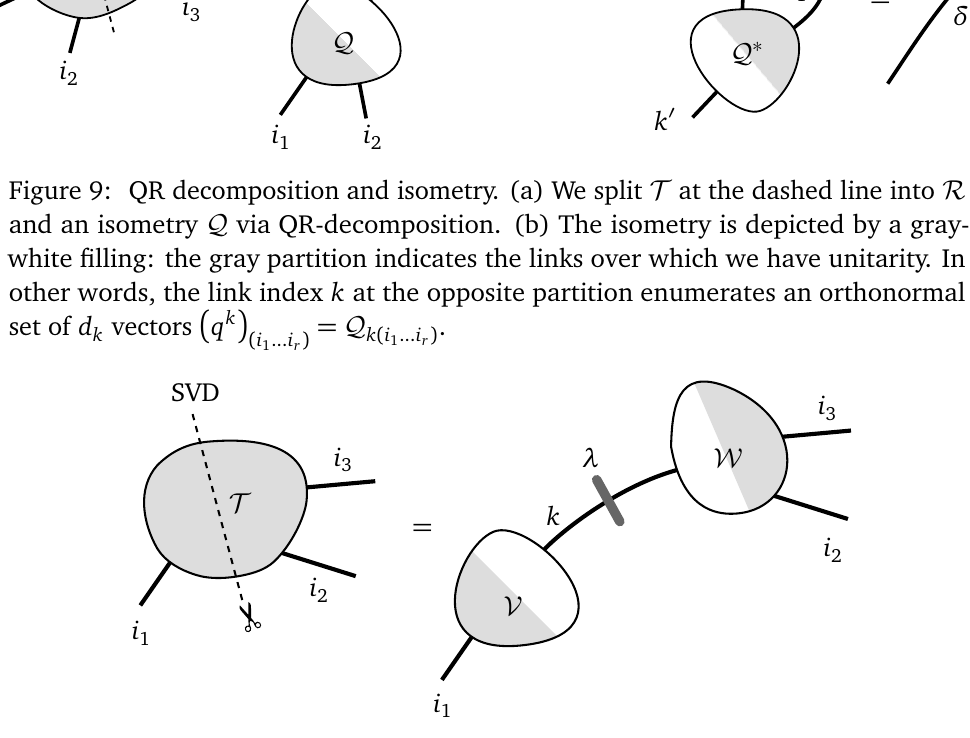
Figure 10: The singular value decomposition of a tensor produces an intermediate link k and two semi-unitary tensors W and V (depicted by shade over the orthonormal link bipartition, cf. Eq. (25)). The singular values appear on the intermediate link as a non-negative diagonal matrix or weights λ , represented by a bar to highlight k the sparsity. Removing singular values from the link (thereby compressing it into a smaller dimension d ) does not disturb the tensor k